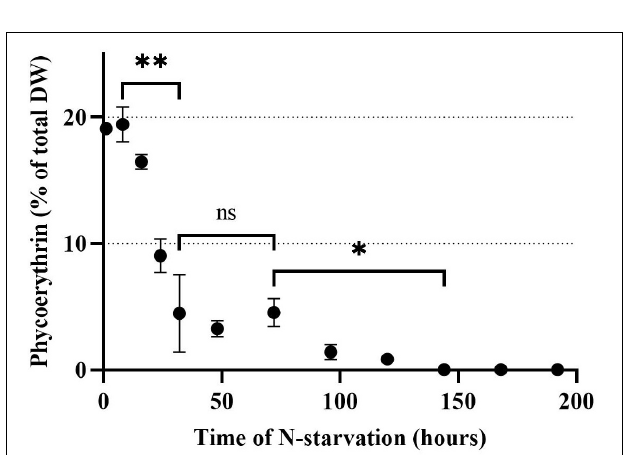
FIGURE 3 | Phycoerythrin concentration of Rhodomonas sp. during a 192 h N-starvation period of time. Data are expressed as the average of three replicates ± SD. *Indicates the significant difference after ANOVA post hoc test. ns P > 0.05, * P < 0.05, ** P <